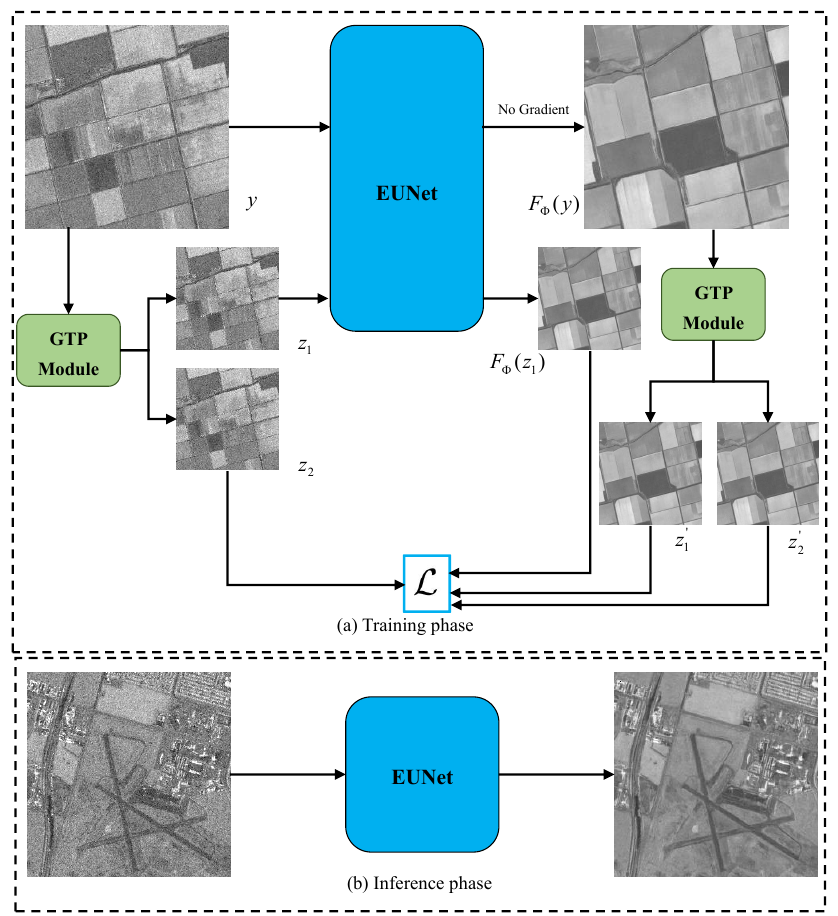
Figure 1. Overview of the proposed SSEUNet framework. ( a ) Complete view of the training phase. ( b ) Inference phase using the trained